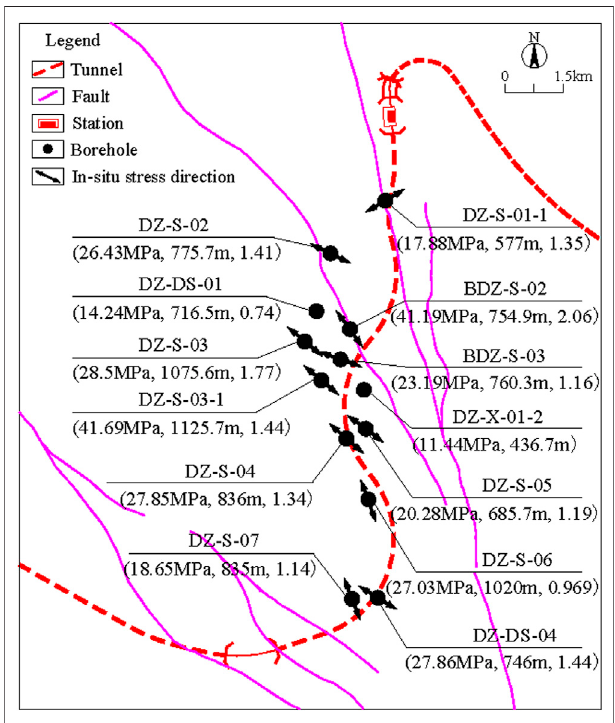
FIGURE 4 | The location sketch of